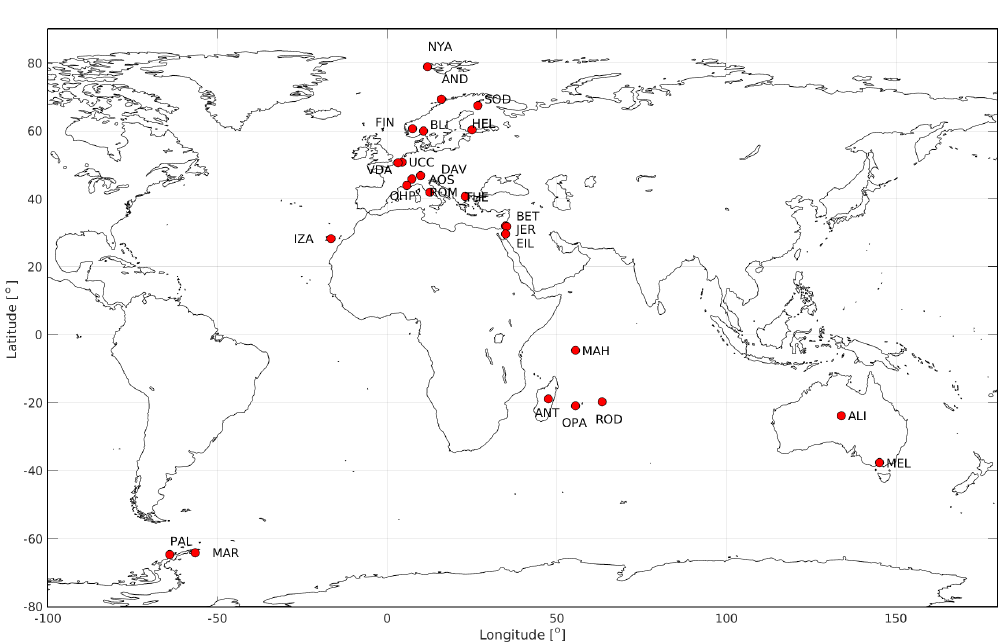
Figure 1. Location of ground-based reference sites. See Table 2 for explanation of site